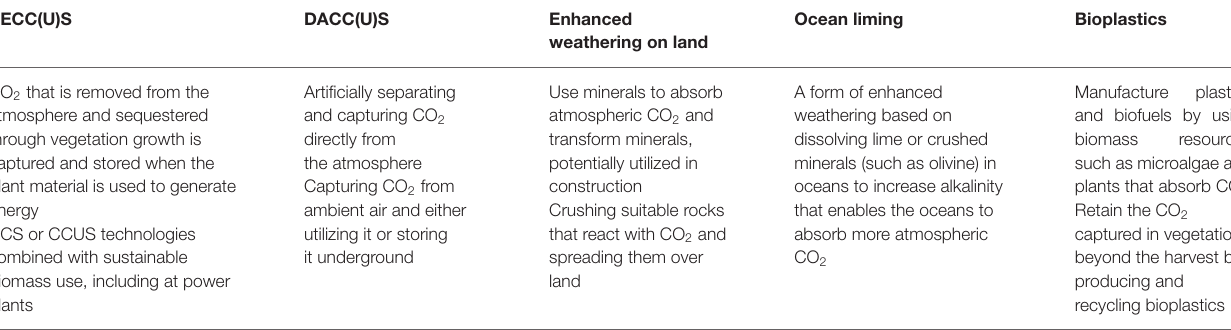
TABLE 3 | Definition and examples of technological carbon sinks as described in the climate strategies.